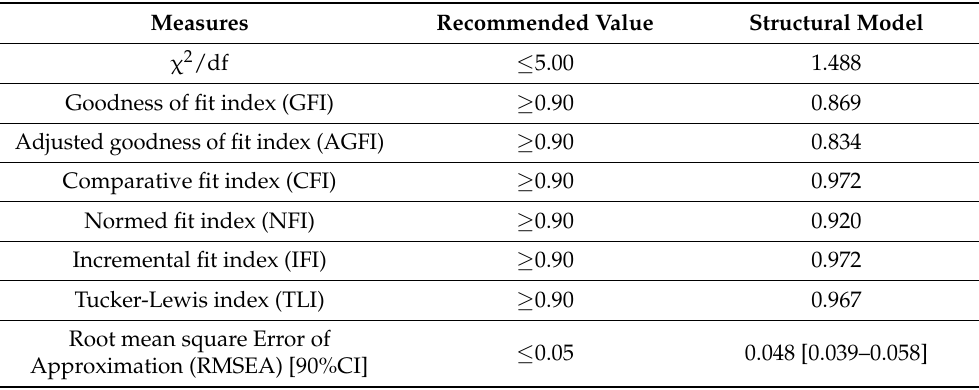
Table 8. Evaluation of model